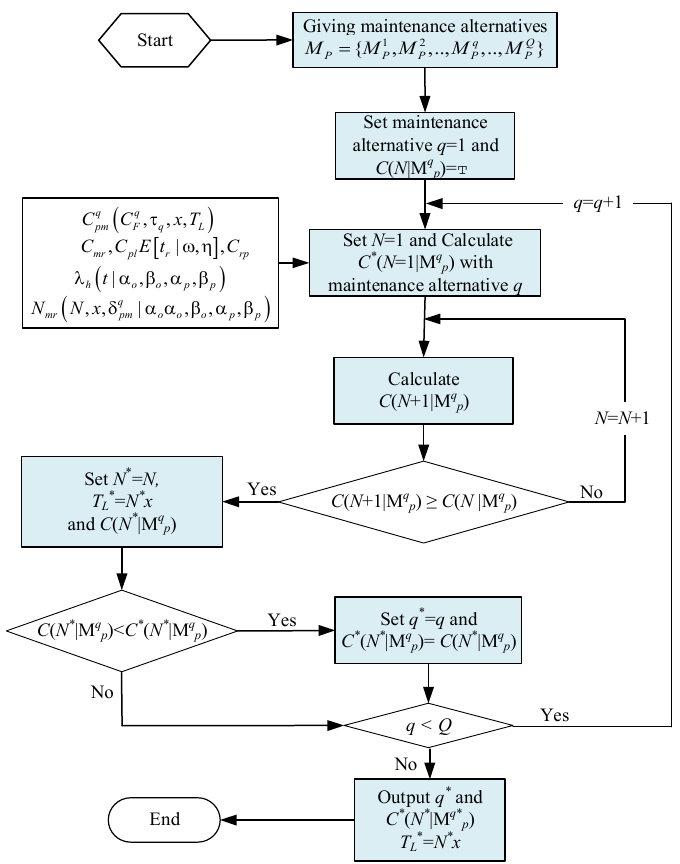
∗ . Figure 3. Heuristic algorithm for obtaining the minimal cost by setting N ∗ and M q ∗ P